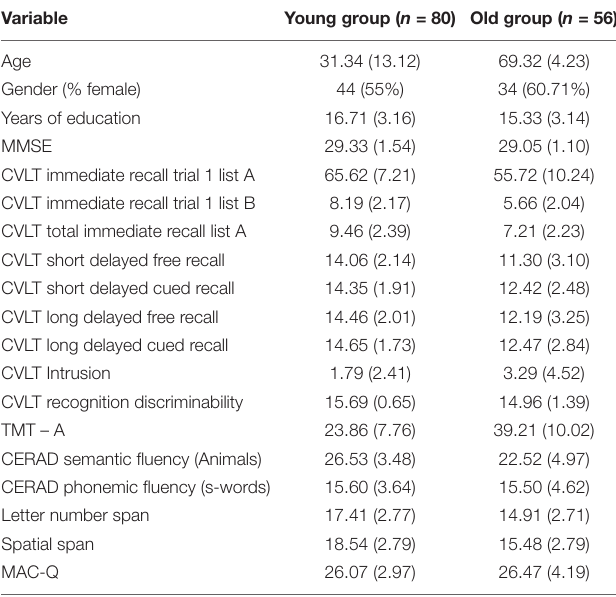
TABLE 1 | Demographic characteristics and neuropsychological tests scores of the study sample.